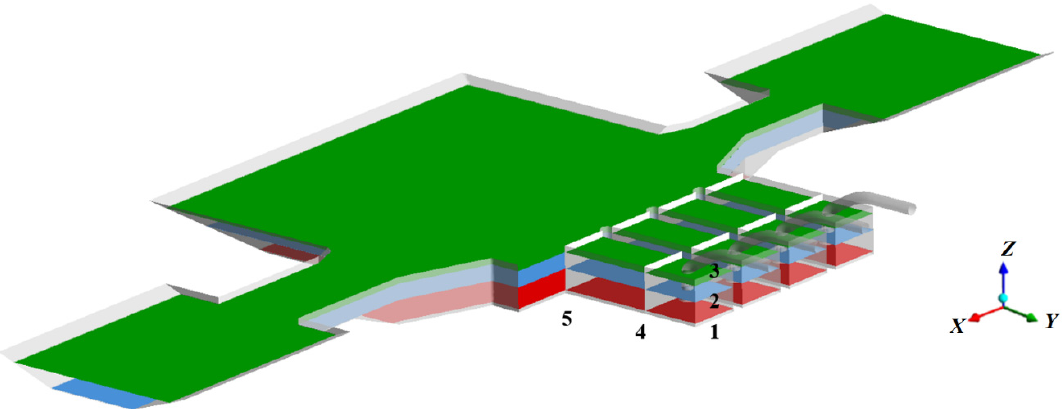
Figure 5. Analysis